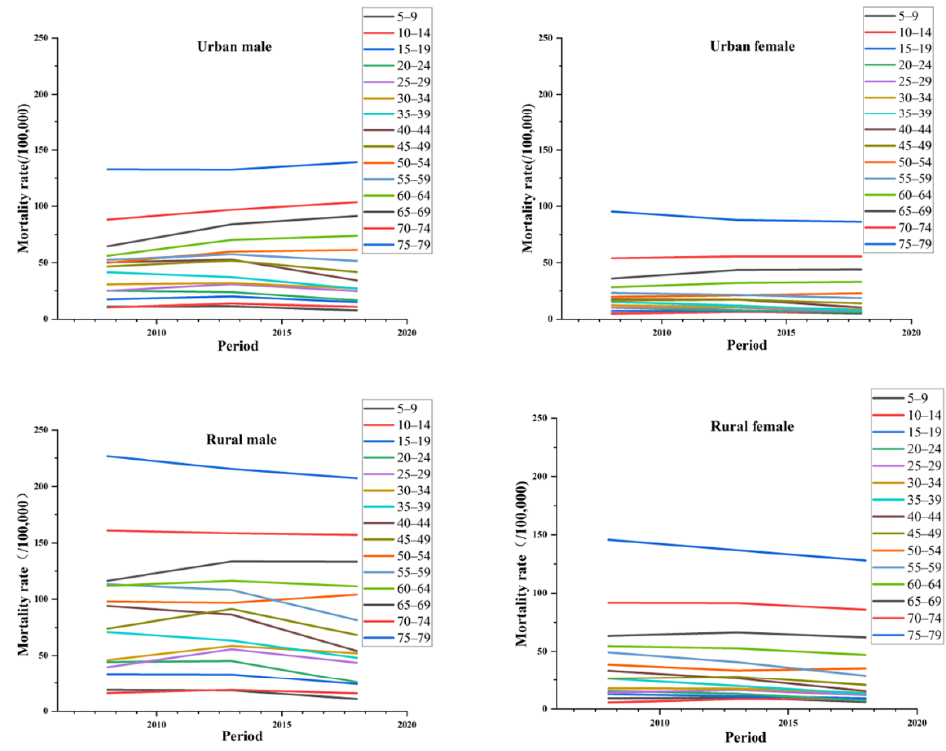
Figure 2. The trends of injury and poisoning mortality in China by gender and region with period.